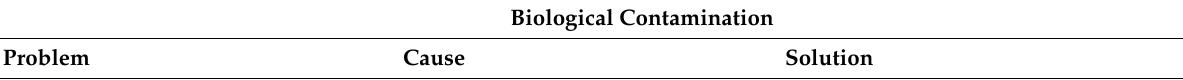
Table 2. Listed are the most frequently occurring challenges concerning biological contaminations with their respective cause and a suggested